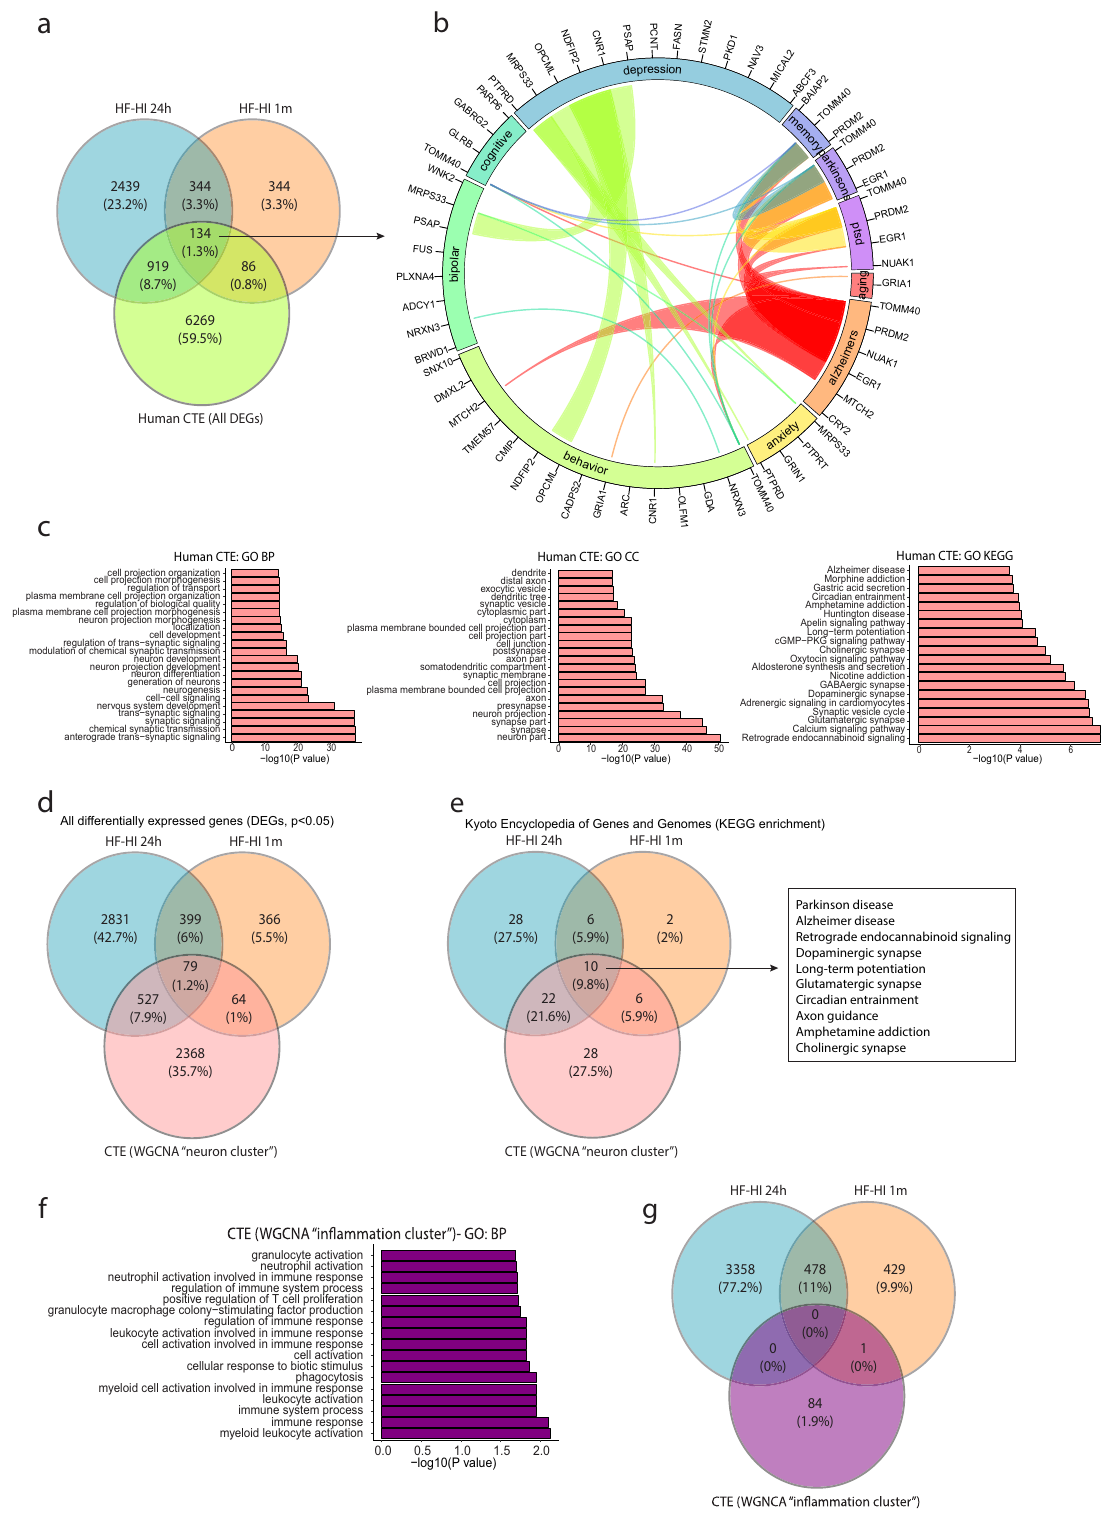
Behavioral dysfunction in rodent models of TBI is well docu- these models present no overt tissue damage, cell death, or lesion mented. Severe models of brain injury, such as controlled cortical formation but do present with white matter degeneration, neu- impact, present with widespread axonal injury, cell death, neu- roin fl ammation, long-term learning and memory de fi cits, and roin fl ammation, and behavioral de fi cits that increase with the increased anxiety- and depressive-like behavior 6,9,13,16,28 – 33 . Of these studies, those that have measured p-tau levels have reported injury severity 26 . Head impact paradigms more analogous to the no changes despite the manifestation of symptoms 34 – 36 . The human condition with respect to maintenance of structural majority of these models do not exceed fi ve head impacts total, integrity and injury conditions are closed-skull models 27 . Many of NATURE COMMUNICATIONS| (2021) 12:2613